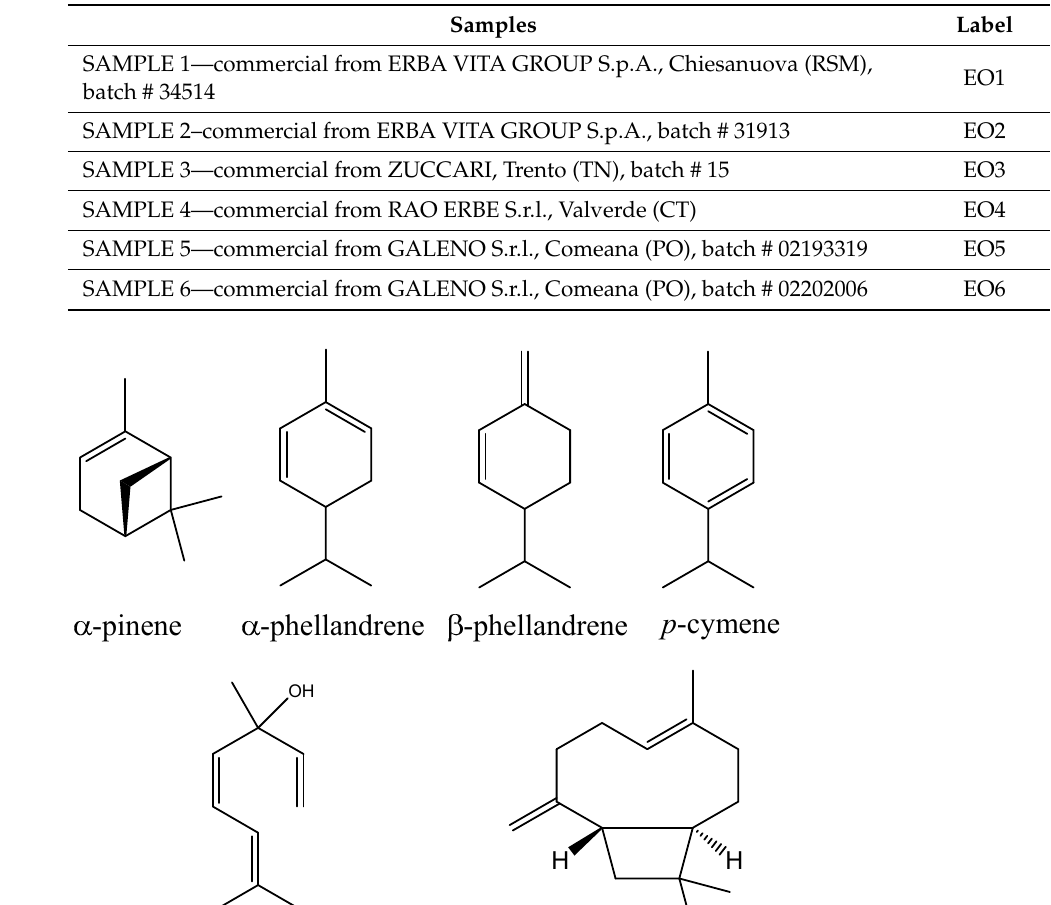
Table 1. Cinnamon essential oil (CINN-EO) samples.